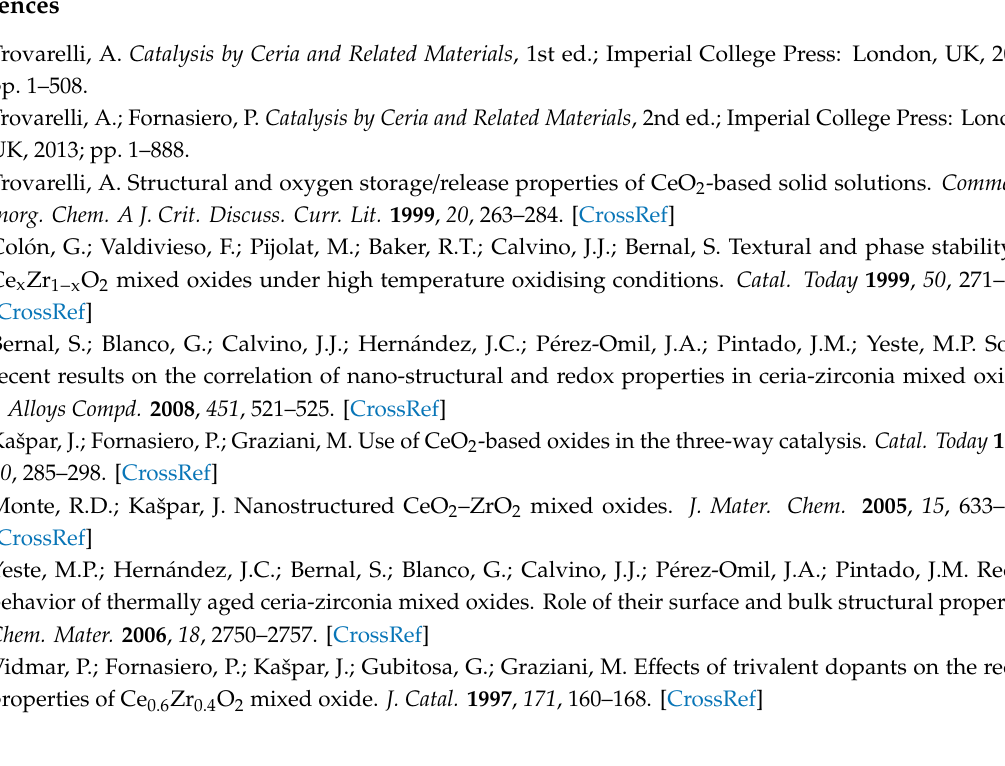
Figure S1: ( a ) Evolution with temperature of mass / charge ( m / z ) ratios 18 and 28 during the TPR-MS analysis of the commercial ZrO 2 nanoparticles used as support, and ( b ) comparison of water evolution curves for the bare nanoparticles and the fresh ZrO 2 -CeO 2 sample, Figure S2: Evolution with temperature of mass / charge ( m / z ) ratios 2 and 28 during the TPR-MS analysis of the fresh samples: ( a ) ZrO 2 -CeO 2 , ( b ) ZrO 2 -Ce 0.87 Y 0.13 O 1.935 , and ( c ) ZrO 2 -Ce 0.87 La 0.13 O 1.935 , Figure S3: Evolution with temperature of mass / charge ( m / z ) ratio 30 during the TPR-MS analysis of the fresh samples: ( a ) ZrO 2 -CeO 2 , ( b ) ZrO 2 -Ce 0.87 Y 0.13 O 1.935 , and ( c ) ZrO 2 -Ce 0.87 La 0.13 O 1.935